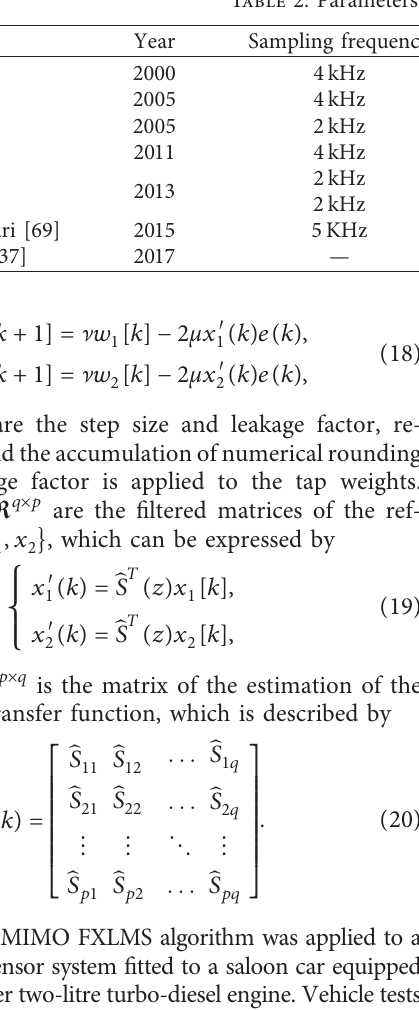
Figure 14: Diagram of normalized FXLMS [65]. Table 2: Parameters in the FXLMS